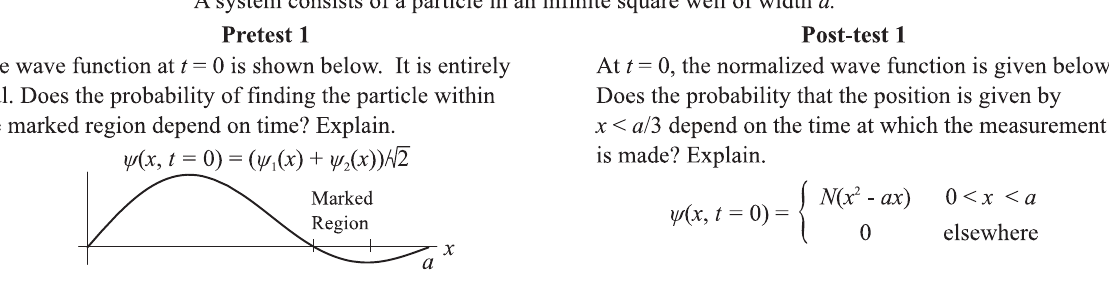
FIG. 2. A pair of questions about the time dependence of position probabilities. The pretest was given after lecture instruction on time dependence but before the tutorials. The post-test was given after the full sequence of three tutorials focusing on quantum measurements and time